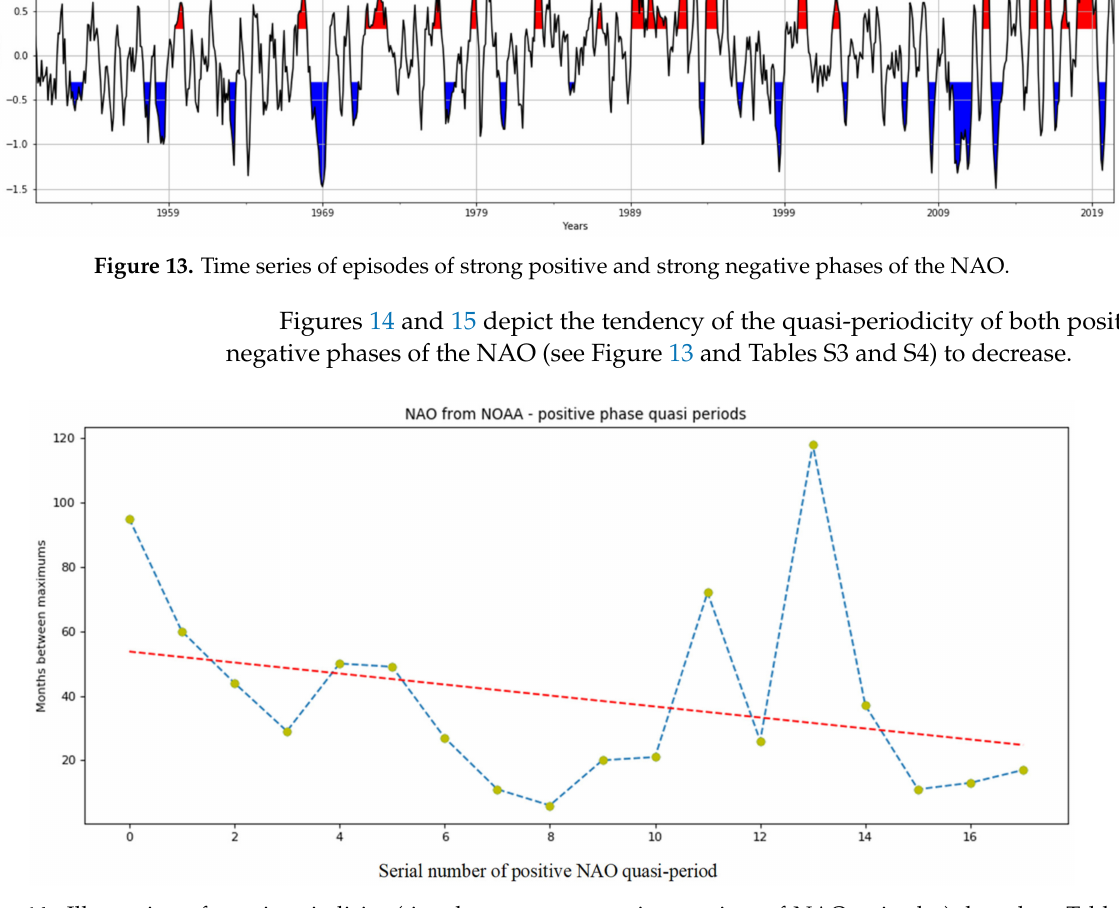
Figure 14. Illustration of quasi-periodicity (time between consecutive maxima of NAO episodes), based on Table S3. Numbers of episodes follow from this